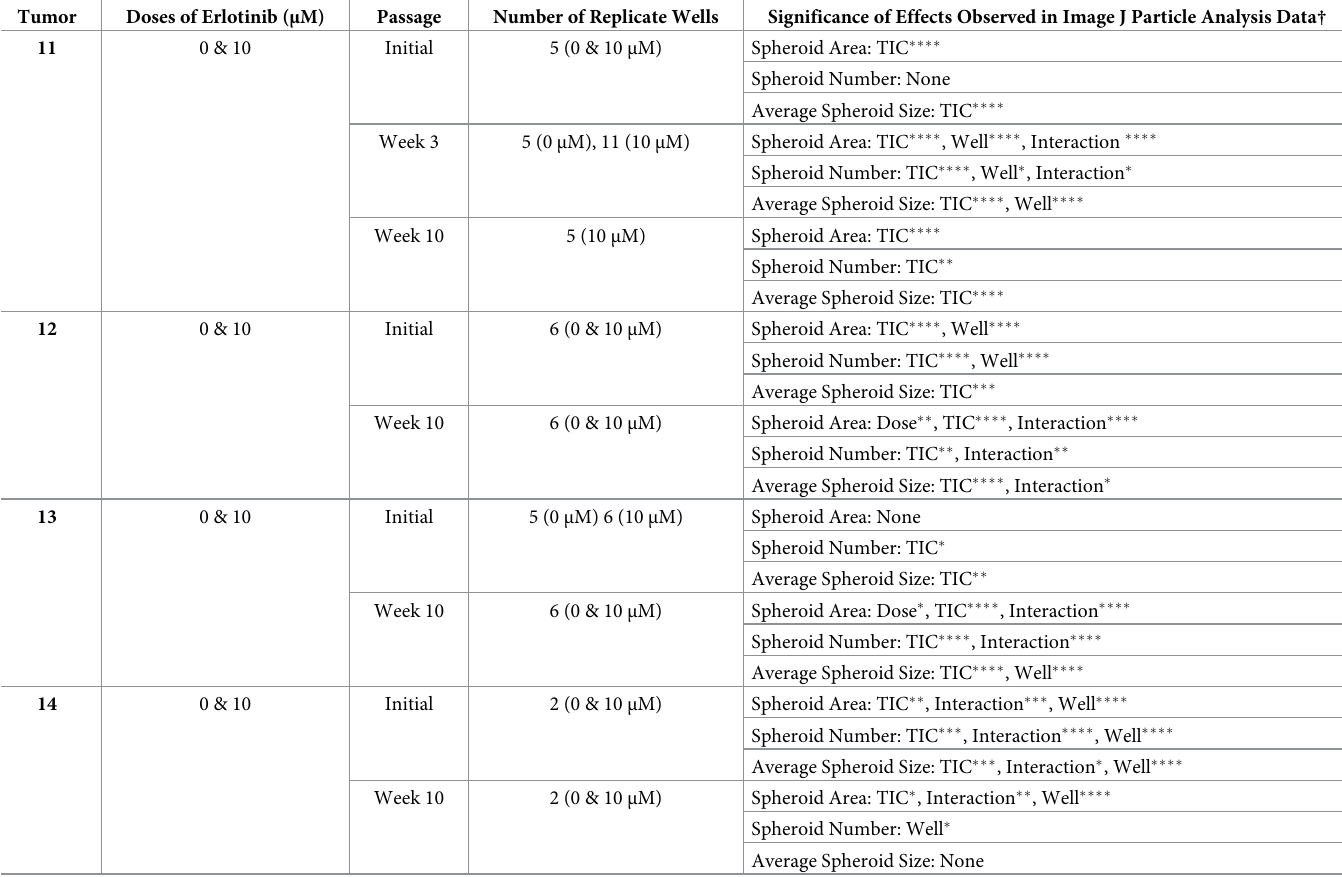
Table 3. Design and effects observed in long-term spheroid culture as assessed by image